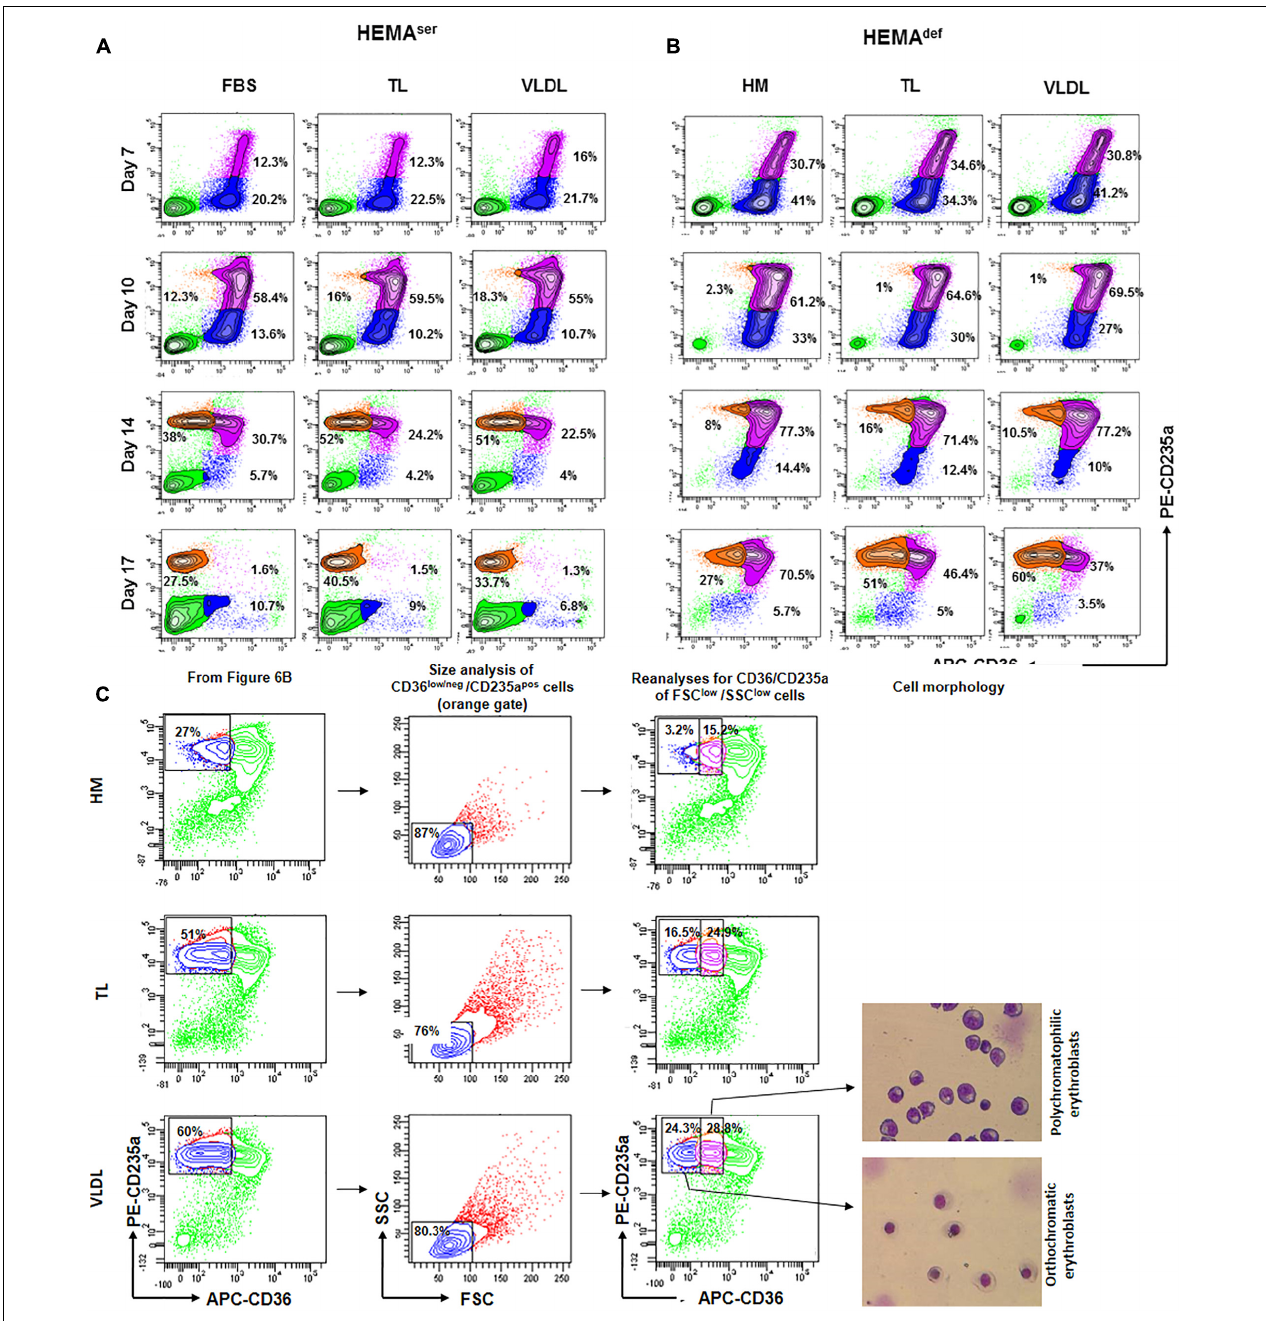
FIGURE 6 | All the lipoprotein fractions increase terminal erythroid maturation under HEMA def conditions. Contour plots for CD36 and CD235a expression obtained by FACS of erythroblasts generated over time in HEMA ser (A) and HEMA def (B) supplemented with TL and VLDL. Cells obtained with FBS or with HM liposomes were analyzed as control. Similar results were observed in cultures supplemented with HDL, LDL and LDL-Sigma (results not shown). Analyses for CD36/CD235a expression identifies five populations corresponding respectively to lymphocytes (CD36 neg CD235a neg cells, bright green); pro-erythroblasts (CD36 pos CD235a neg cells, blue); basophilic-erythroblasts (CD36 pos CD235a high cells, purple); and polychromatophilic/orthochromatic (CD36 neg CD235a high cells, orange) erythroblasts. The frequencies of pro-erythroblasts, basophilic and poly/orthochromatic erythroblasts are indicated within the quadrants. Results are representative of those obtained in two separate experiments. (C) Contour plot for forward scatter (FSC) and side scatter (SSC) of the days 17 cells in the CD36 low / neg /CD235a pos gate of Figure 6B . The cells were then re-analyzed for CD36/CD235a expression, sorted and stained with May-Grunwald Gimsa. The numbers inside the panels indicate the frequency of the cells in the different gates. This analysis allows discriminating between erythroid cells at the polychromatophilic and orthochromatic stage. Only results obtained in the HM, TL, and VLDL group are presented. The results obtained with TL and VLDL are representative of those obtained with HDL, LDL, and